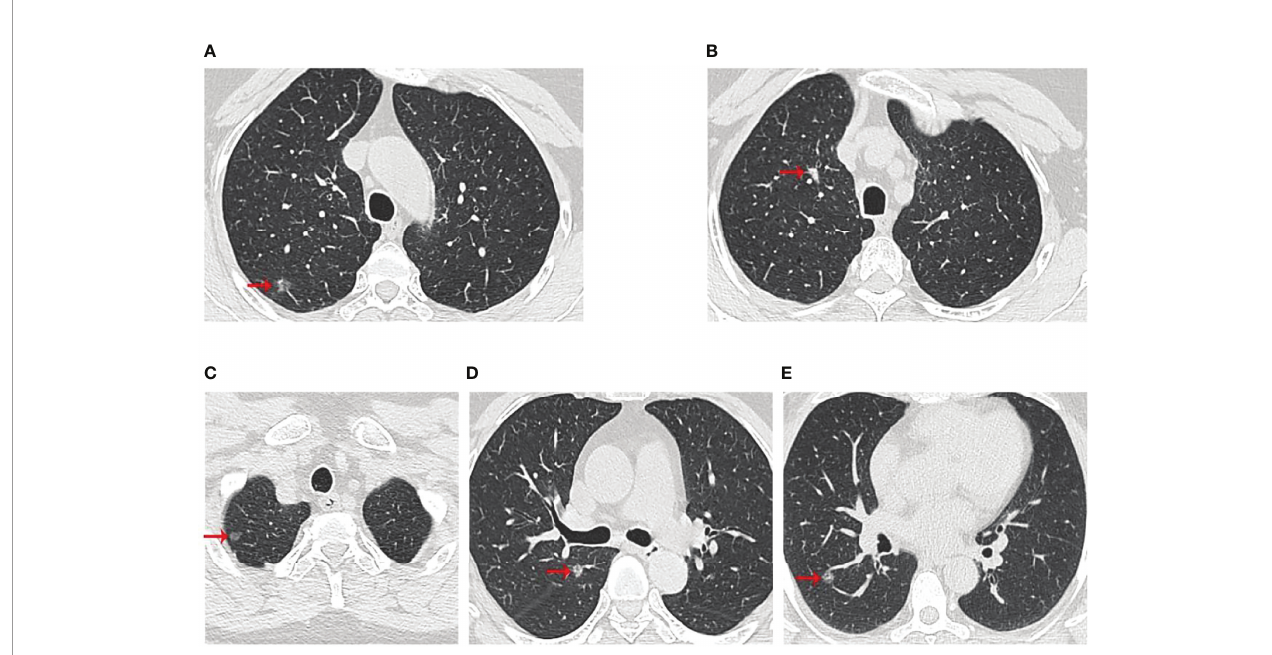
FIGURE 2 | Computed tomographic scan of chest at diagnosis of three patients. (A, B) were II-2 CT scan results, which showed two nodules in the upper right lobe; (C, D) were II-4 CT scan results, which showed two nodules in the upper lobe of the right lung; (E) was II-5 CT scan results with a right lower lobe nodule. The red arrows indicated the location of the